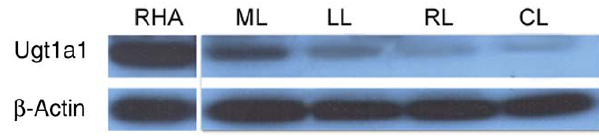
Figure 5. Western blot for ugt1a1 in the Gunn rat liver following HIR to 2/3 of liver and hepatocyte transplantation. Three months after hepatocyte transplantation, ugt1a1 protein was demonstrated in the irradiated and unirradiated liver lobes of Gunn rats by western blot analysis. However, the ugt1a1 content in irradiated lobes was much higher than that of unirradiated lobes. RHA, Wistar- RHA rat liver; ML, median lobe; LL, left lobe;, RL, right lobe; CL, caudate